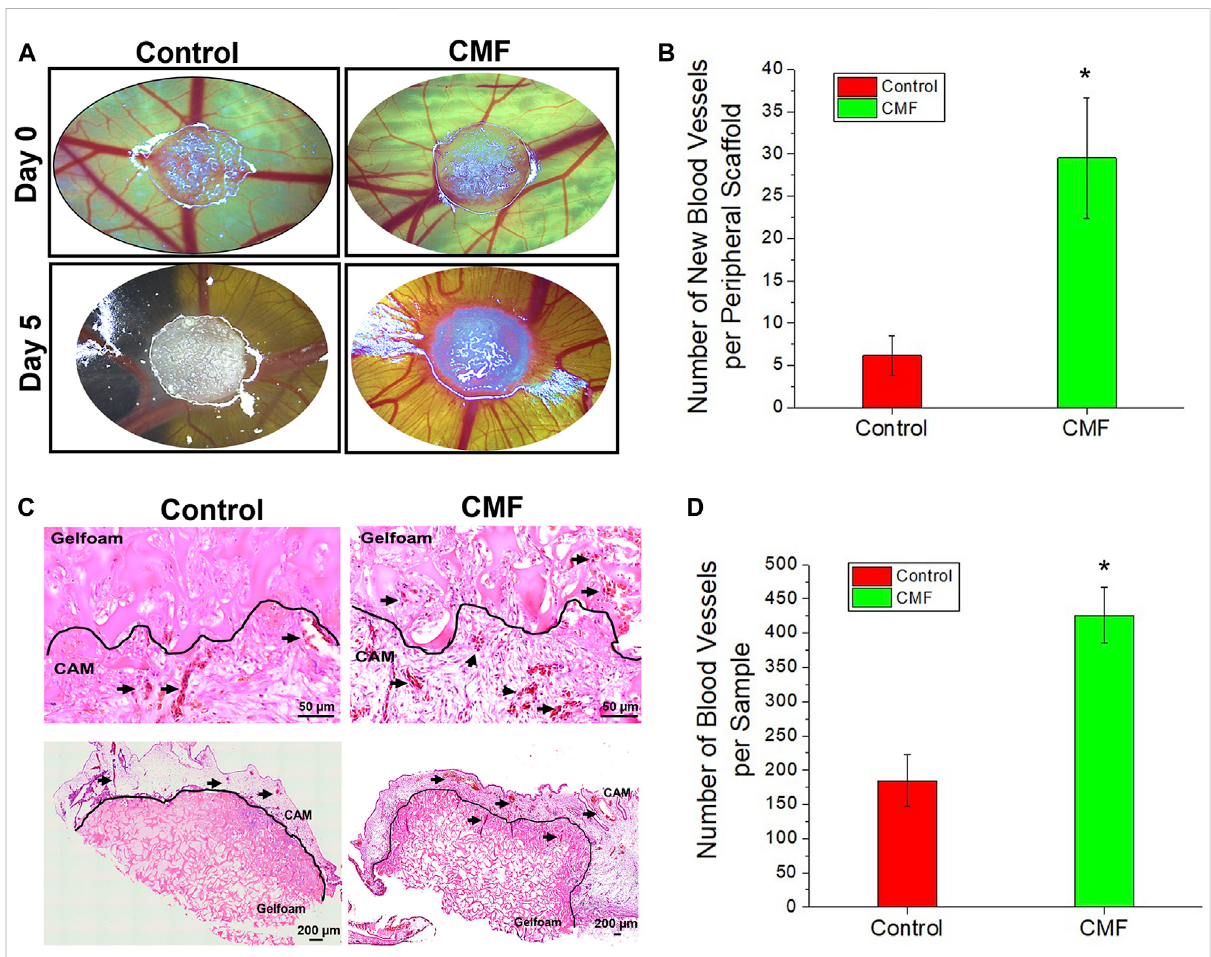
FIGURE 7 Angiogenic properties of CMF in in ovo chick chorioallantoic membrane (CAM) assay. Gelfoam scaffold treated with CMF (6×) and Control (PBS) is implanted on CAM,incubated in ovo for 5 days, and blood vessel formation is evaluated. (A) Bright fi eld images of CAM model at day 0 and day 5. (B) Quantitative analysis of newly formed blood vessel peripheral to scaffold after 5 days implantation ( n = 6 per group, T-Test, and Welche ’ s correction * p < 0.05 with control). (C) Histological analysis of vertical and horizontal sections through CAM. Upper panel: H&E (Scale bars: 50 μ m) of vertical sections. Bottom panel: H&E (Scale bars: 200 μ m) of horizontal sections. (D) Quantitative analysis of blood vessel per H&E day 5 images ( n = 4 per group, T-Test, and Welch ’ s correction * p < 0.05 with